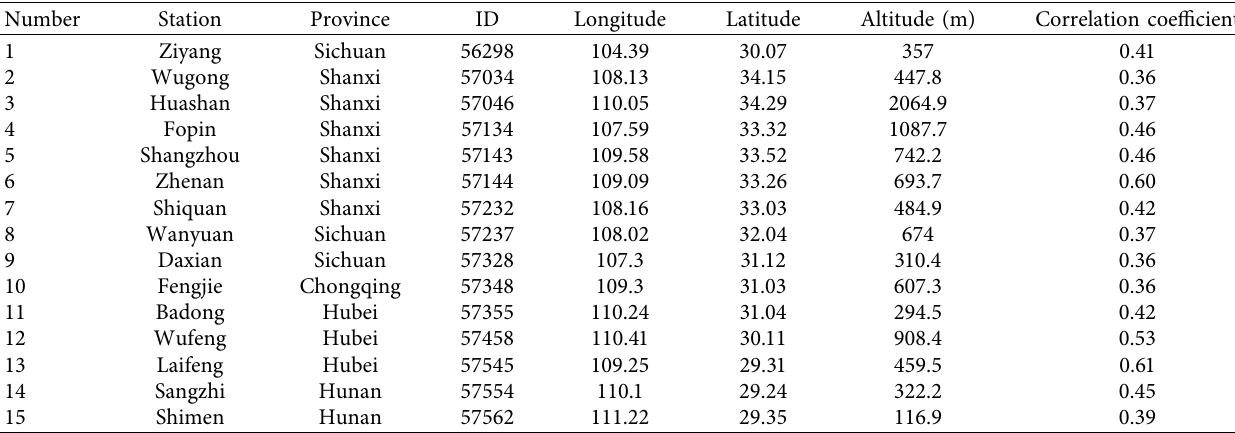
Figure 1: Distribution of correlation coefficients between the summer precipitation and prewinter Niño3 SSTindex from 1979 to 2008. The contour lines denote the correlation coefficients above the 95% confidence level. The shaded area denotes the altitude (units: m). The black dots denote the stations in the western mountainous regions with the correlation coefficients between the JJA precipitation and the prewinter Niño3 SST above 95% confidence level. Table 1: Information of stations in the western mountainous regions with correlation coefficients between the JJA precipitation and prewinter Niño3 SST index from 1979 to 2008 above the 95% confidential